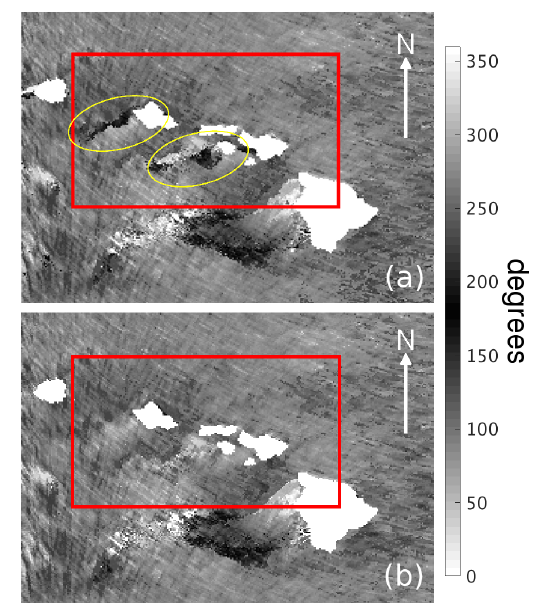
Figure 10. QuikSCAT UHR-derived wind direction fields for different median filter window sizes. ( a ) shows a swath oriented wind direction field of a simulated HRCM wind field nudged with the true wind field. ( b ) shows ( a ) processed with a 42.5 km (17 x 17 UHR WVC) median filter window. Note how the dark features that differ from the mean flow (circled within the red box) in ( a ) disappear in ( b ) after filtering. The land mask is shown in white and the colorbar denotes the wind direction in